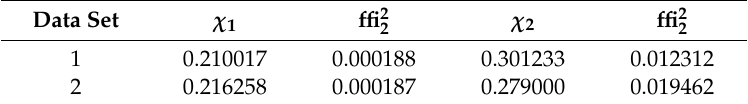
Table 4. Table of